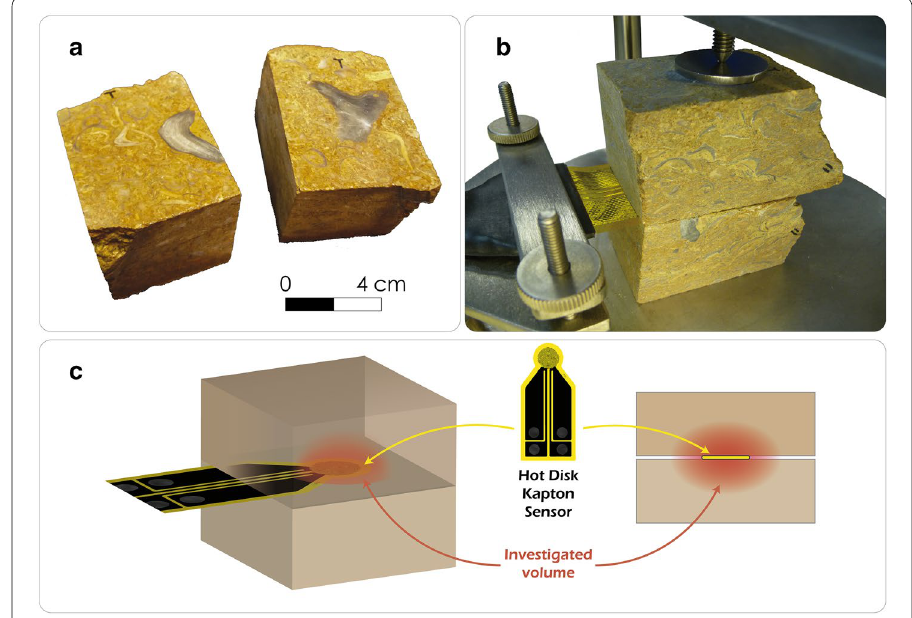
Fig. 4 a Example of a sample prepared for thermal conductivity measurements (sample J-CE; Calcaire d’Ettendorf ). The samples were cut and polished to produce at least two planar and parallel surfaces. b Double-sided thermal conductivity measurement on J-CE sample in the dry state at ambient temperature. The two pieces of sample are placed either side of the sensor. The pieces are clamped together, to ensure a good contact between the pieces of sample and the sensor, using a metal screw at the top of the jig. c Schematic showing the setup and the volume around the sensor (probing depth) investigated during the